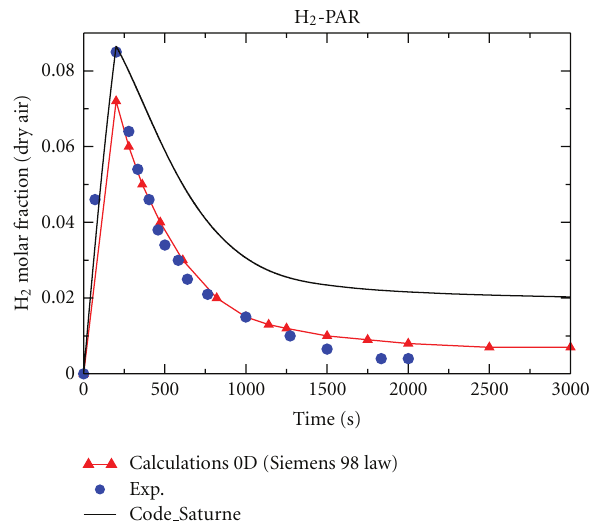
Figure 4: E19 test—time evolution of hydrogen molar fraction.